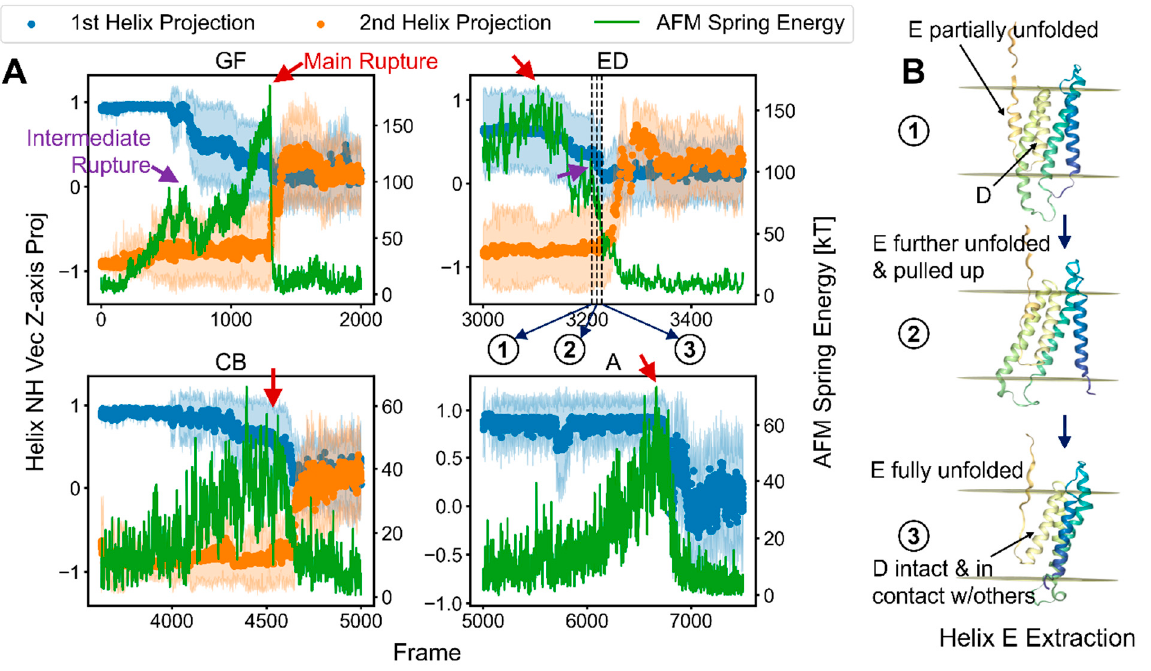
Figure 6. NH bond vector projections onto the z-axis as measures of helix rotation and unfolding. ( A ) Example of projections from a particular replica divided into time frames of the different helix (pair) rupture events. Red arrows point to the main rupture events corresponding to maximum AFM spring energies/pulling forces, while purple arrows provide examples of intermediate rupture peaks that coincided with partial unfolding. ( B ) Trajectory snapshots corresponding to the dotted time points in the ED panel of Subfigure ( A ) highlighting the order of unfolding events of the ED helices.